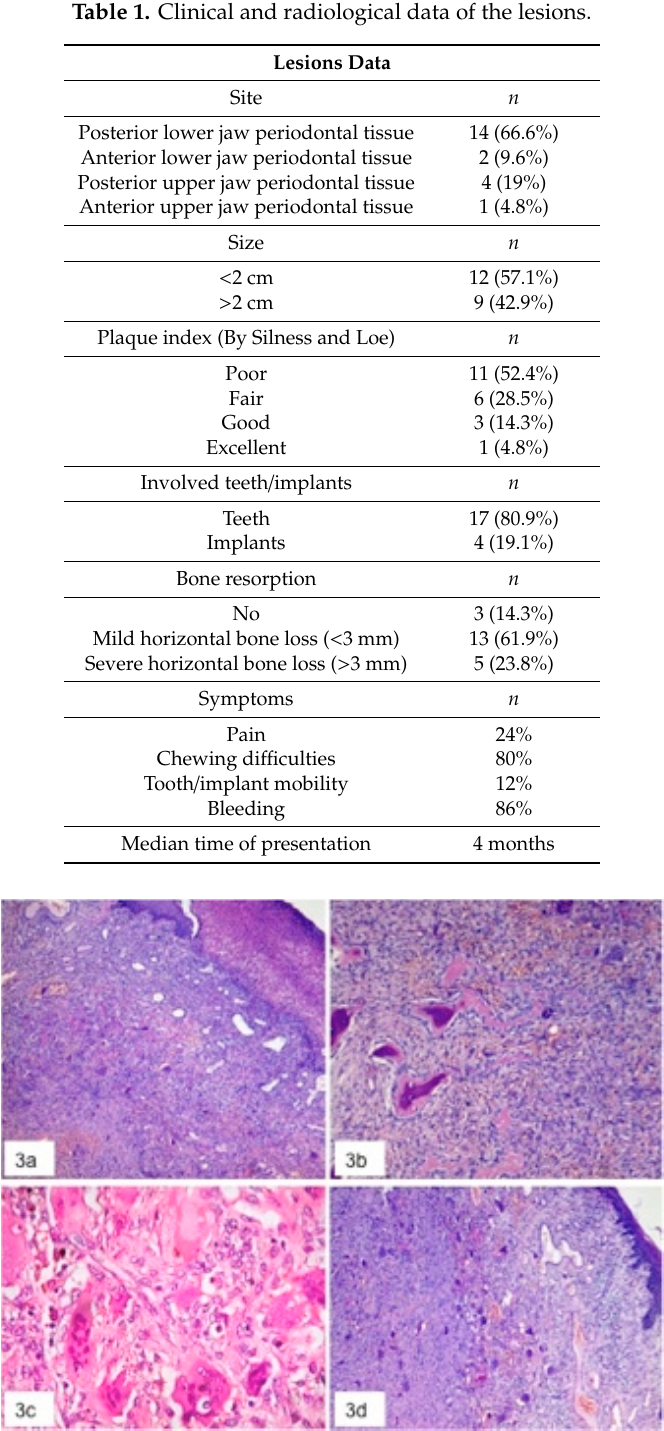
Figure 3. Histological aspects of peripheral giant cell granulomas (PGCG) with giant cells and stromal new formed osteoid bone. ( a ) Panoramic view of PGCG with ulcerated covering mucosa in the upper right region; ( b ) Thin trabecular osteoid bone with surrounding cellular stroma with spindle-shaped fibroblast-like cells ( c ) 40× magnification showing giant cells with variable number of nuclei and different shapes ( d ) Panoramic view with many giant cells surrounded by stroma.